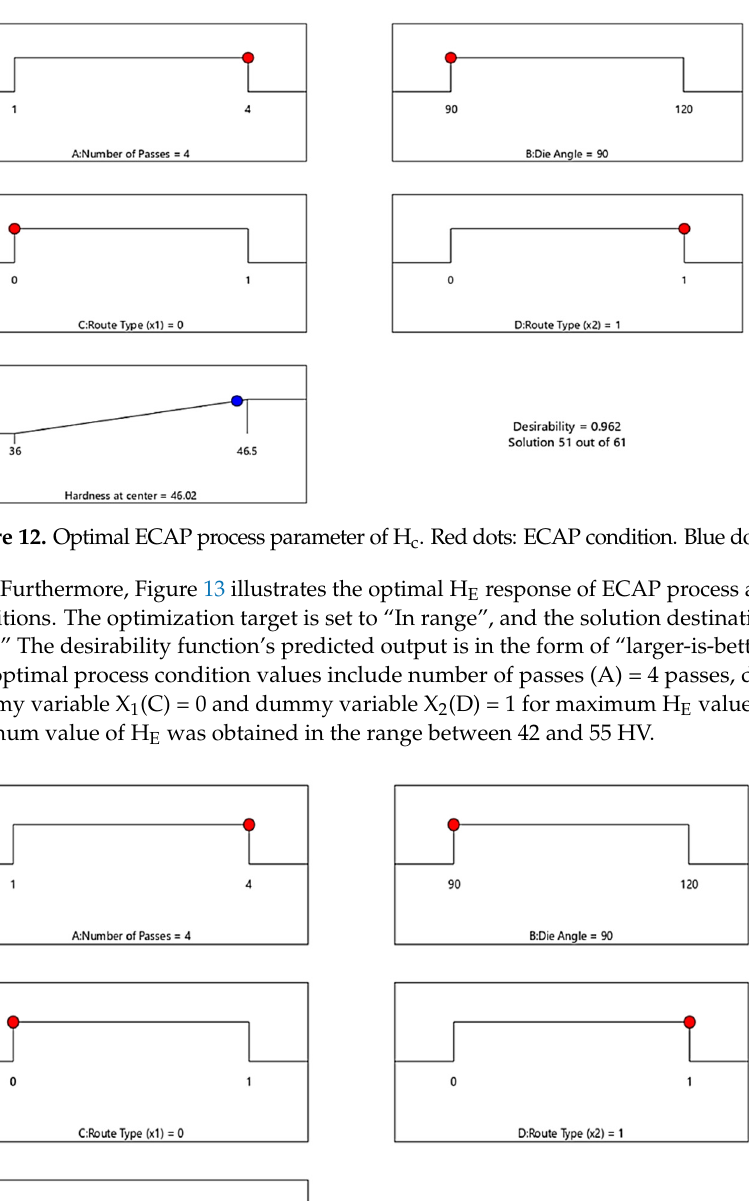
Figure 11. Optimal ECAP process parameter of G R . Red dots: ECAP condition. Blue dots: ECAP response.